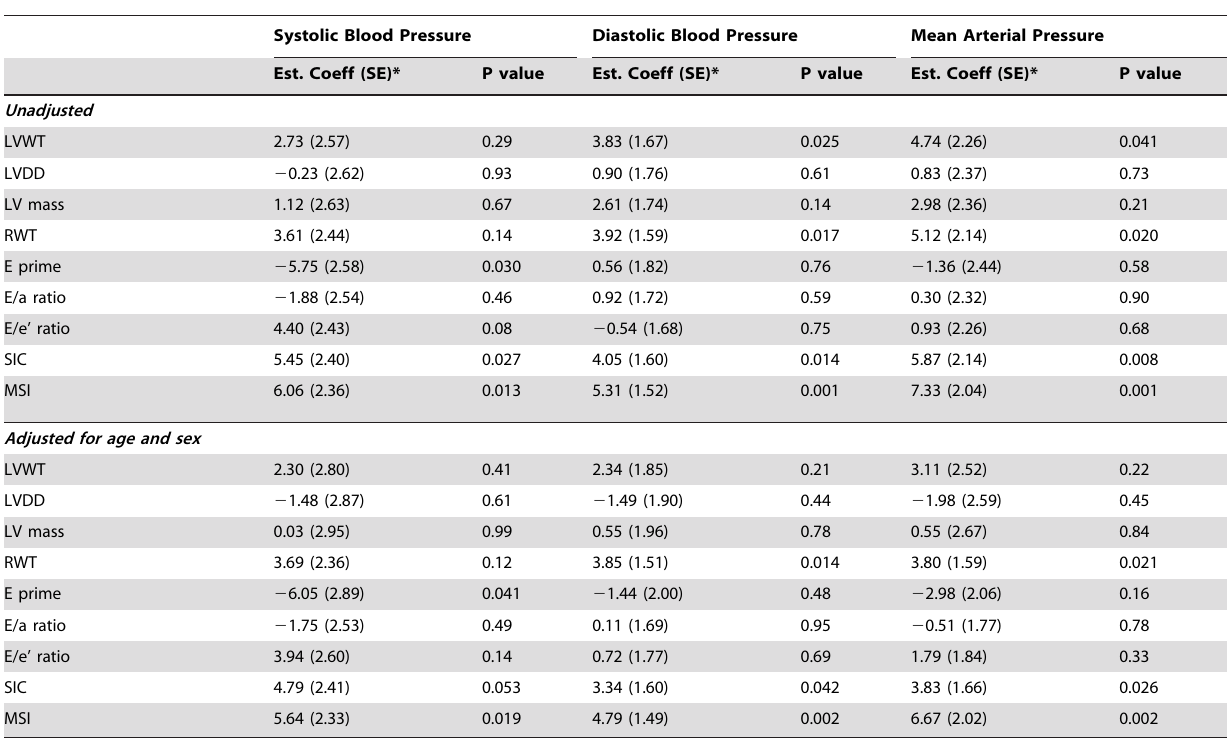
Table 3. Associations of Echocardiographic Parameters with Blood Pressure